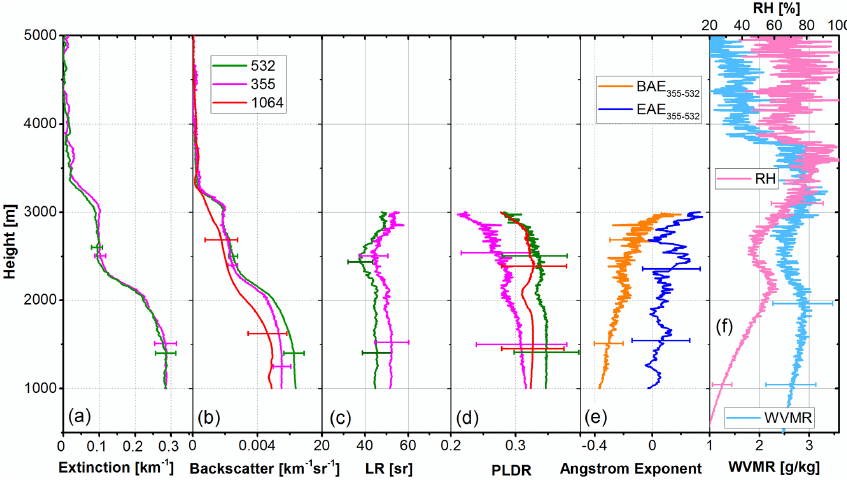
Figure 12. Case 4: lidar-derived parameters at 14:00–16:00UTC, 3 April 2019. (a) Extinction coefficient, (b) backscattering coefficient,